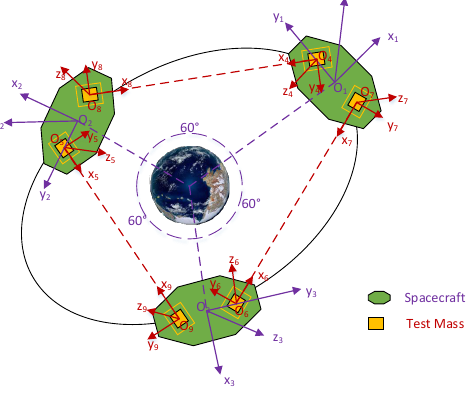
Figure 1. Desired formation configuration for the gravitational-wave detection